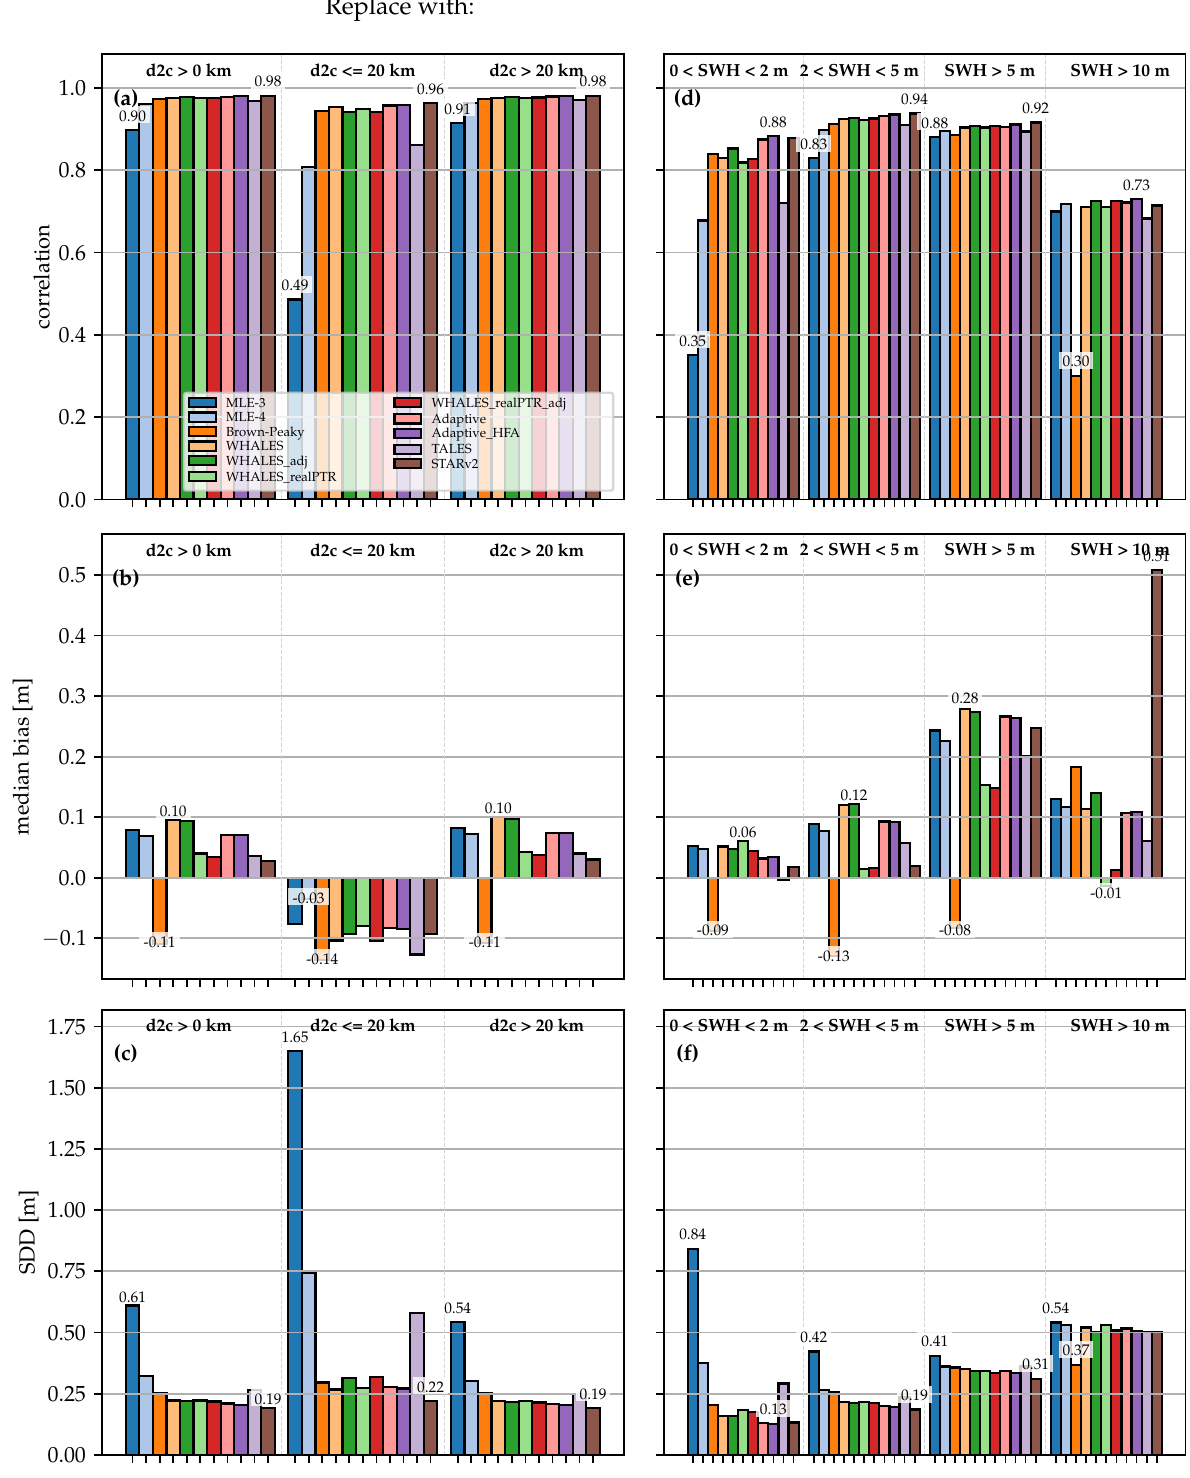
Figure 9. Comparison of the ( a / d ) correlation coefficient, ( b / e ) median bias, ( c / f ) SDD against ERA5-h model of the individual J3 retrackers as a function of dist2coast and of SWH, respectively. (Revision of original Figure